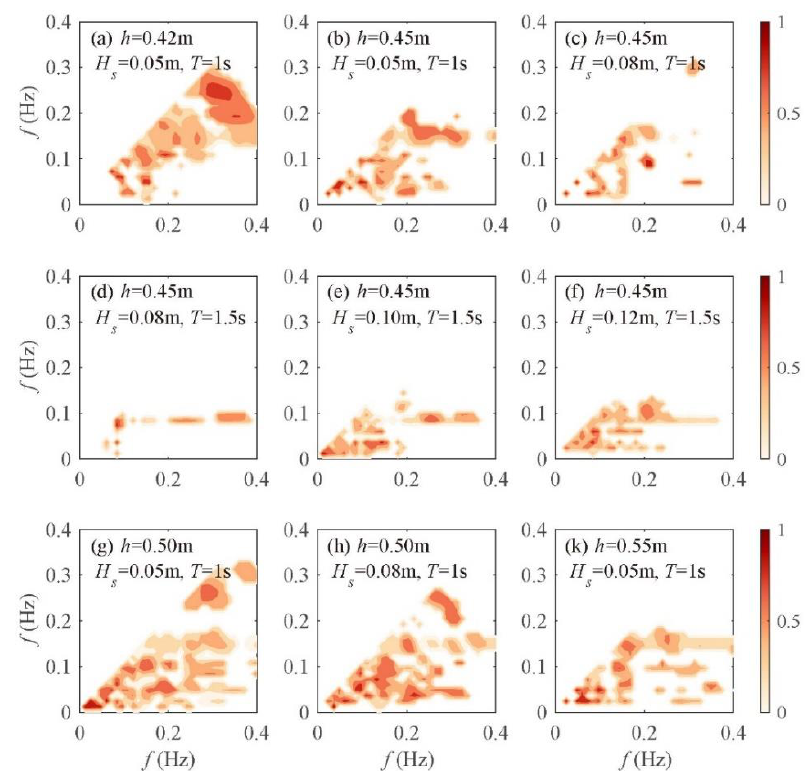
Figure 11. Swash bicoherence of different experiment conditions: ( a ) T00, ( b ) T01, ( c ) T02, ( d ) T03, ( e ) T04, ( f ) T05, ( g ) T06, ( h ) T07, ( k ) T11. Xlabel and Ylabel are wave components frequency. Colorbar denotes the degree of swash bicoherence.